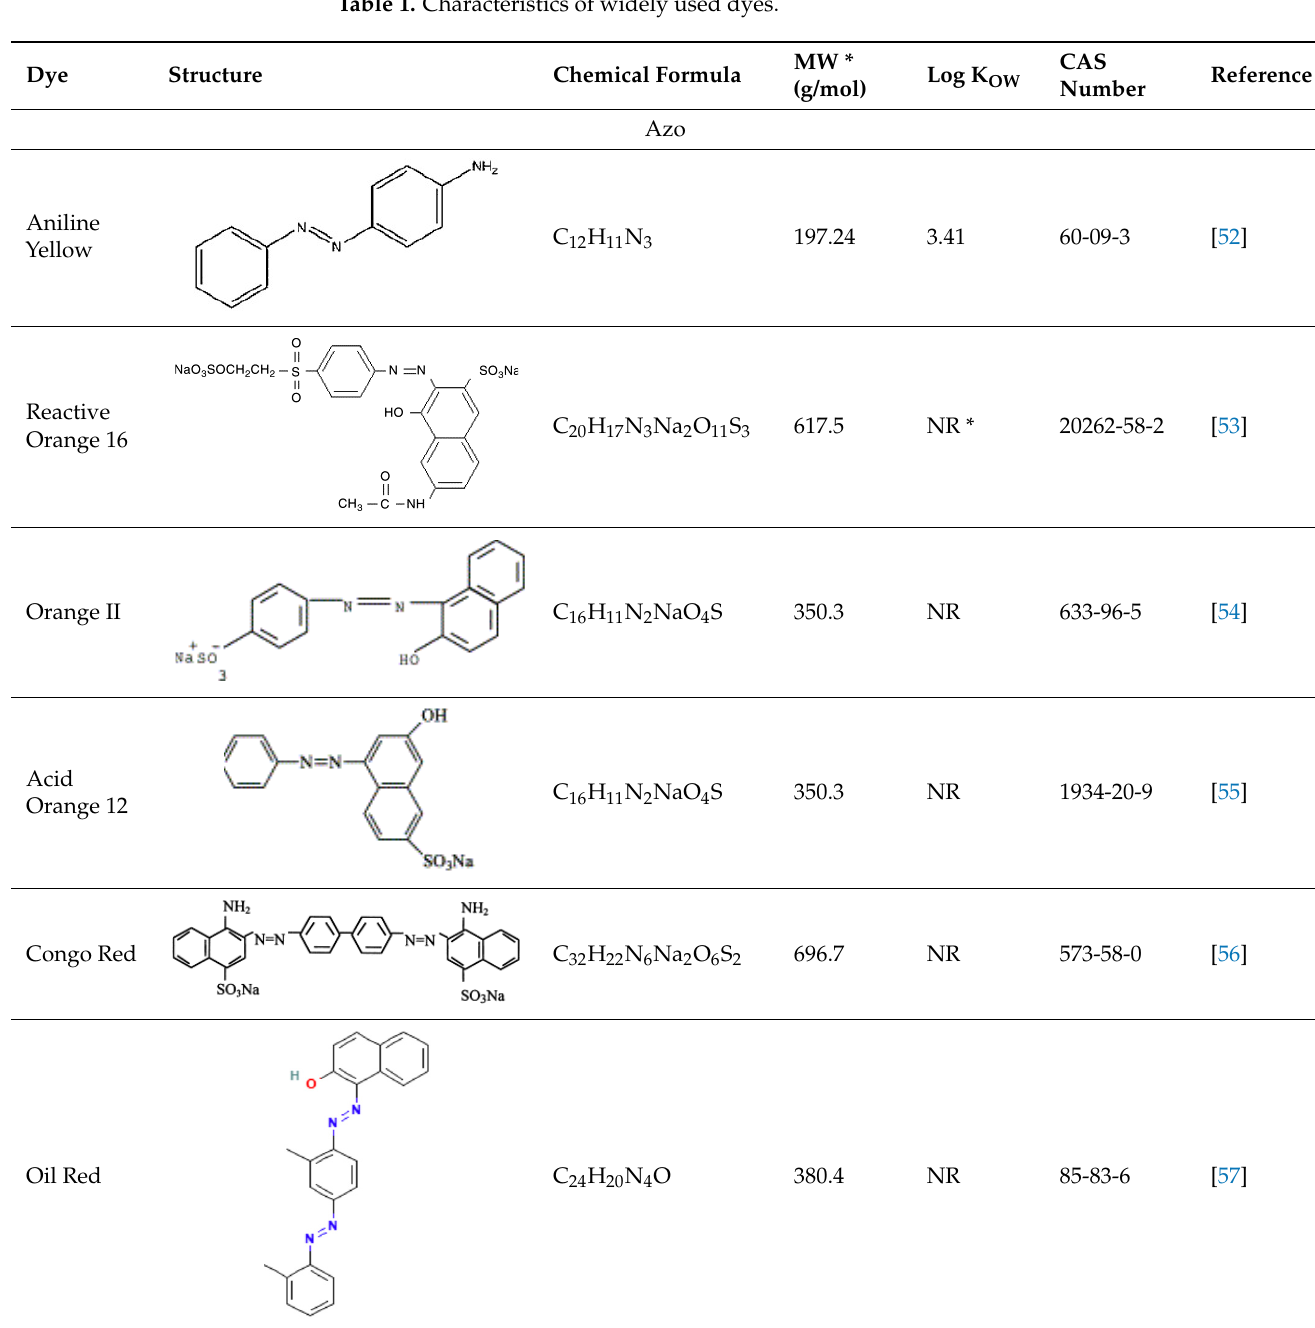
Table 1. Characteristics of widely used dyes.